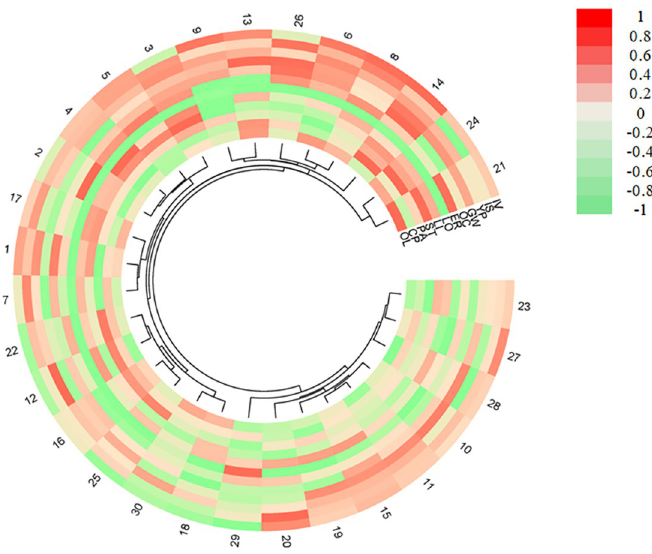
Fig 5. Hierarchical cluster analyses of traits of different high-oleic rape germplasms.